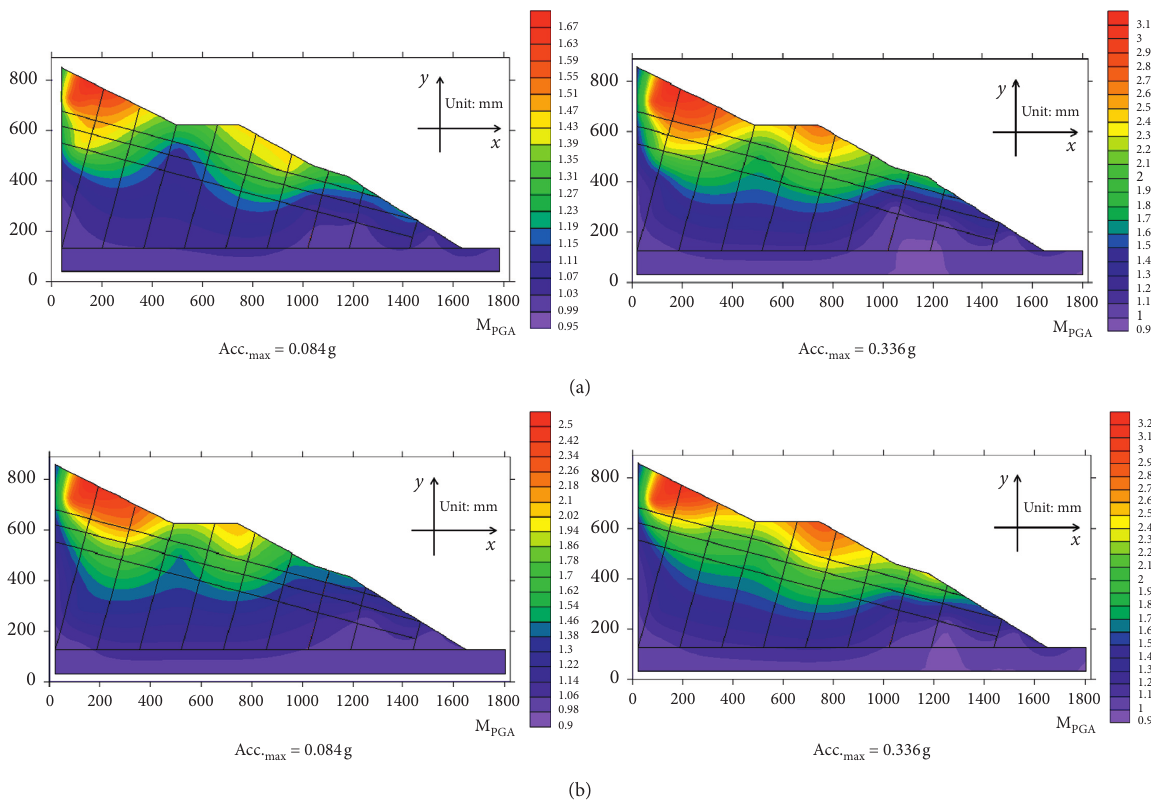
Figure 14: Acceleration amplification coefficient distribution of the Lijiang slope model: (a) input in z direction; (b) input in x direction.